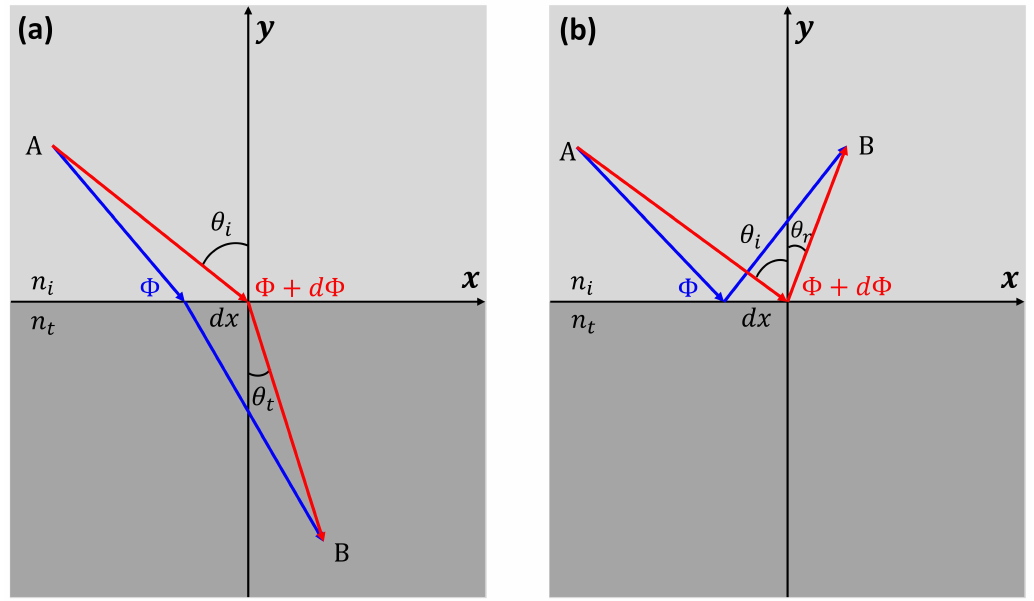
Figure 10. Schematics of the generalized Snell’s law of refraction ( a ) and reflection ( b ). dx is the distance between two beams at the plane of incidence. Φ is the phase shift of the blue beam and Φ + d Φ is the phase shift of the red